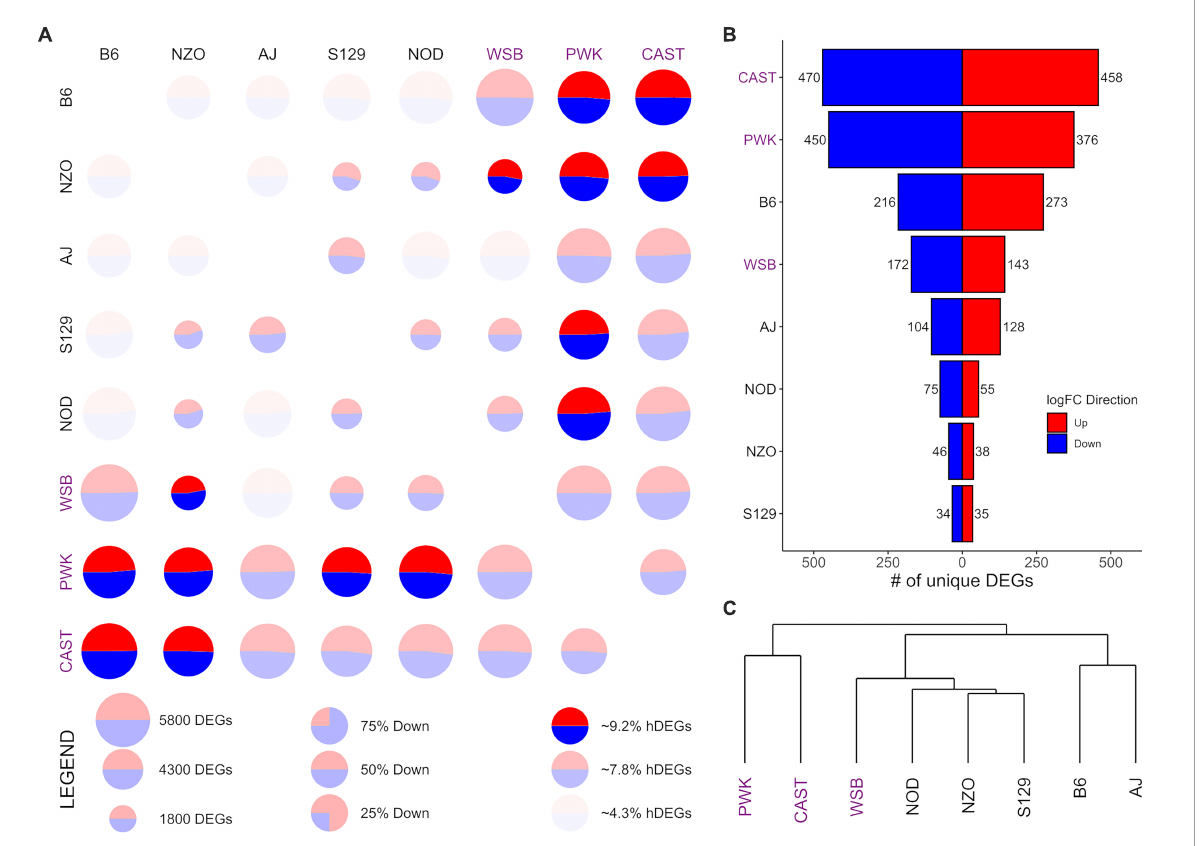
FIGURE2 Differential expression (DE) for central nucleus of the amygdala (CeA) samples from the Collaborative Cross founder strains. (A) Pairwise DE for founder strains where comparisons are made across a row (e.g., B6 vs. CAST is the upper right circle). For each comparison, the visualization shows: (1) CIRCLE SIZE—corresponding to the total number of differentially expressed genes (DEGs) (FDR < 0.05); (2) CIRCLE COLOR—the ratio of blue (down) to red (up) corresponding to the ratio of down to up DEGs; (3) CIRCLE OPACITY—corresponds to the number of highly DEGs (hDEG; log fold change > 1), where the upper quartile are the brightest, the lower quartile are the dimmest. (B) The number of down (blue) and up (red) unique DEGs between a given strain and all others. (C) A phylogeny of the founder strains generated via hierarchical clustering using Manhattan distance on log fold change. Wild-derived strains PWK, CAST and WSB, denoted by purple text, have the highest number of hDEGS (A) , and unique DEGs (B) . Among the classical inbred laboratory strains, the B6 demonstrated the highest differentials for hDEGs and unique DEGs. B6 and AJ clustered separately from the remaining classical inbred laboratory strains and WSB, while PWK, and CAST were clustered separately from all other strains (C)